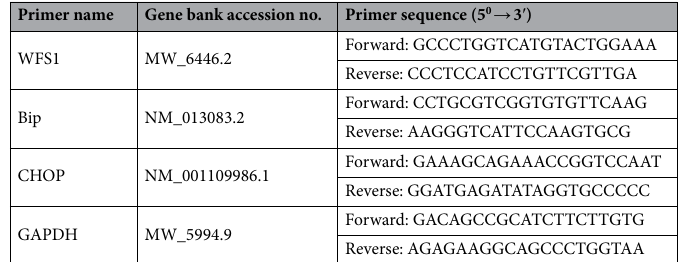
Table 4. Primers used for real-time PCR